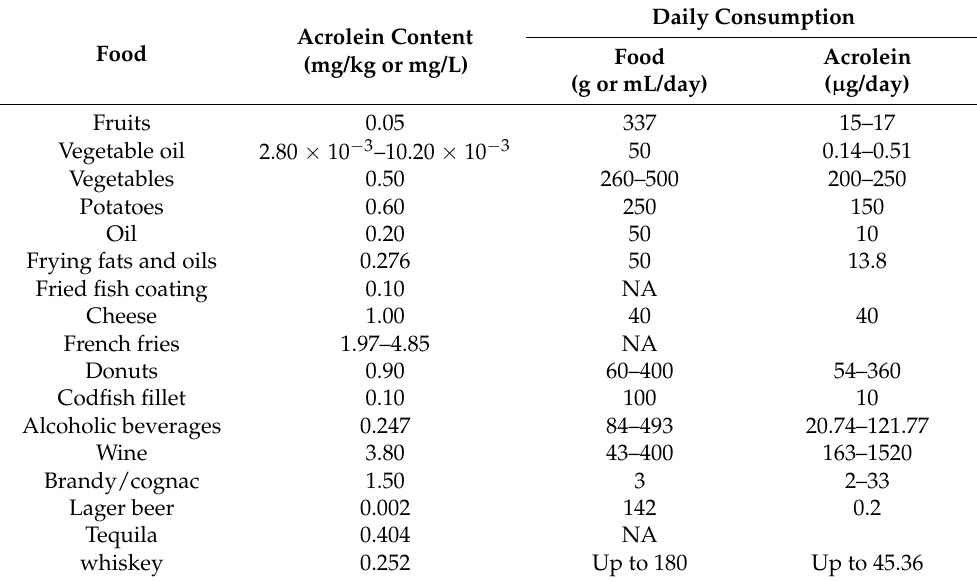
Table 1. Daily acrolein consumption from